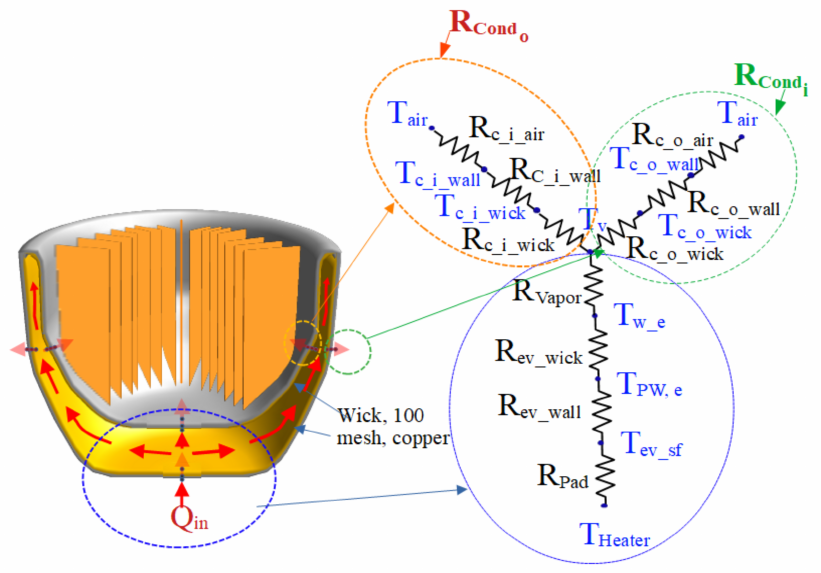
Figure 6. Resistance network model of the hemispherical shell vapor